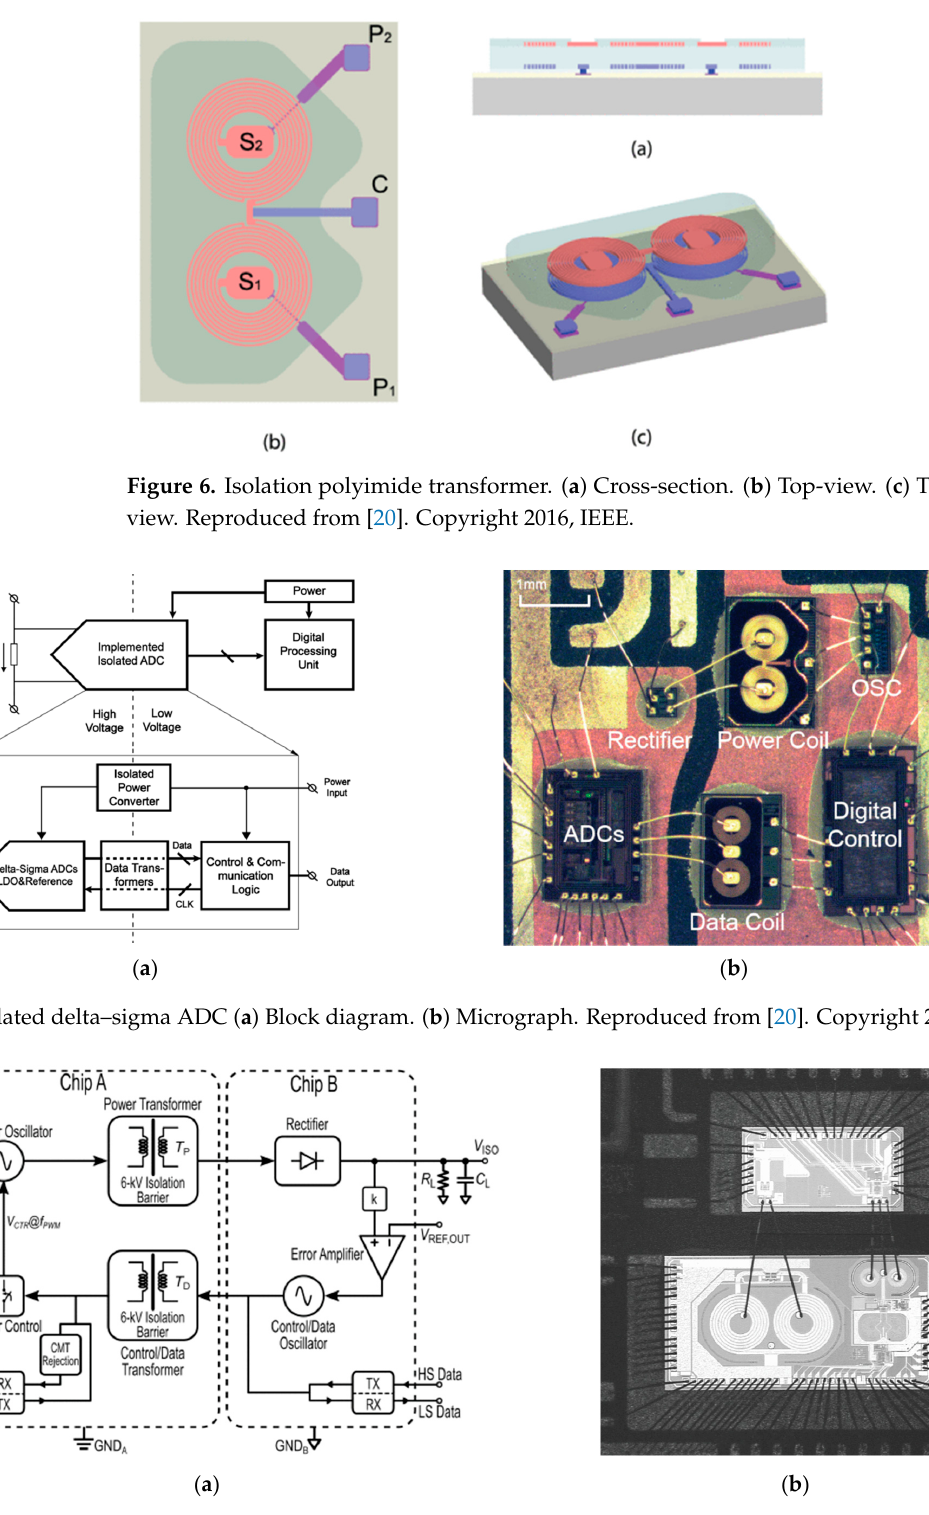
Figure 8. DC–DC converter with bidirectional data communication ( a ) Block diagram. ( b ) Micrograph. Reproduced from [22]. Copyright 2018, IEEE.